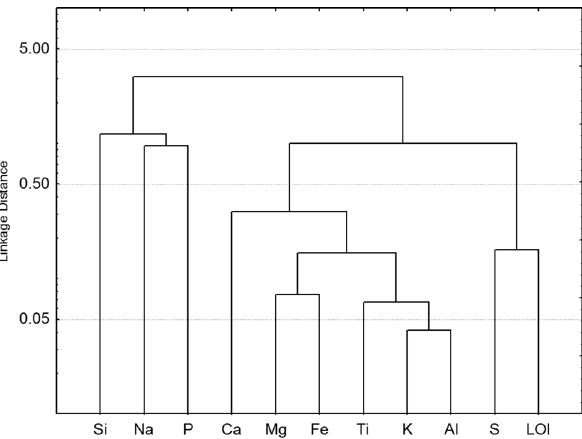
Figure 2: Cluster analysis dendrogram indicating association of Al, K and